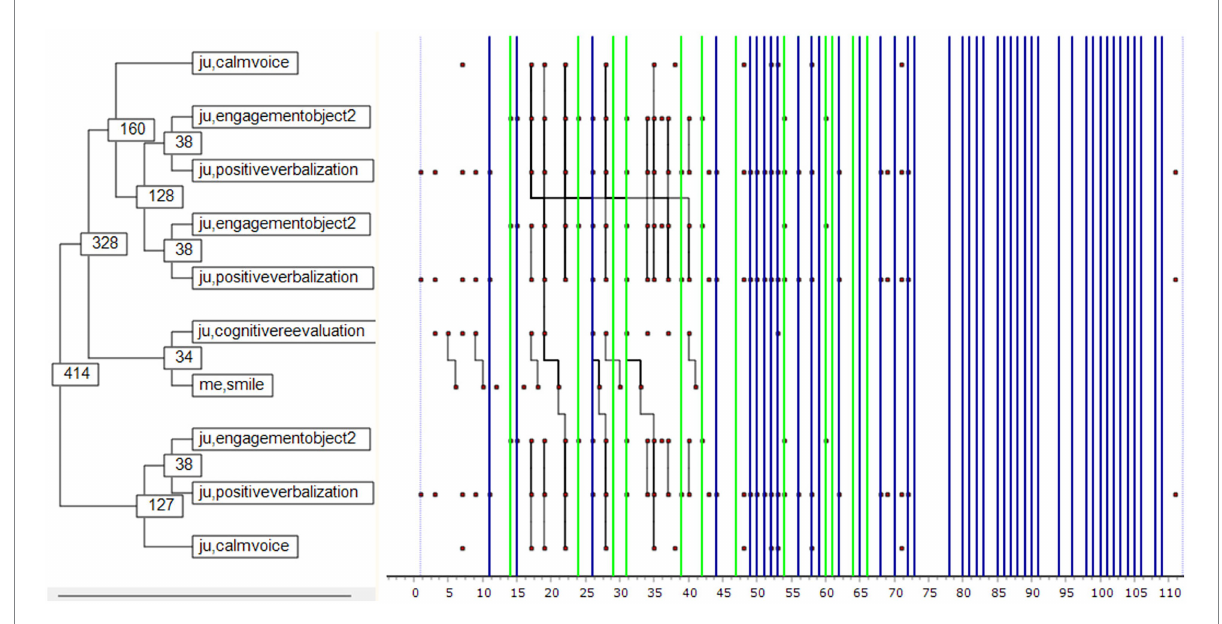
FIGURE 4 Julia-Mother interaction pattern. ju: Julia, me: mother. The X-axis shows the number of behavioral units occurring within the selected 2-min interaction (111 acts overall). Green lines highlight the disengagement behaviors and blue lines are related to self-excitement attitudes. The numbers appearing in the left side of the figure are related to an identification number of each node and is not related with the appearing occurrence of each behavior.